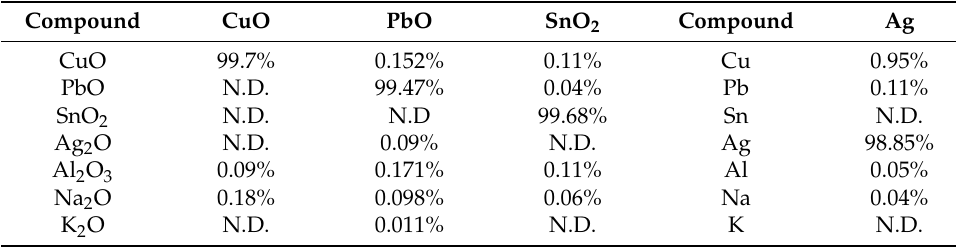
Figure 12. TGA analysis of the metal hydroxides. Table 6. Mass fraction of impurities in the